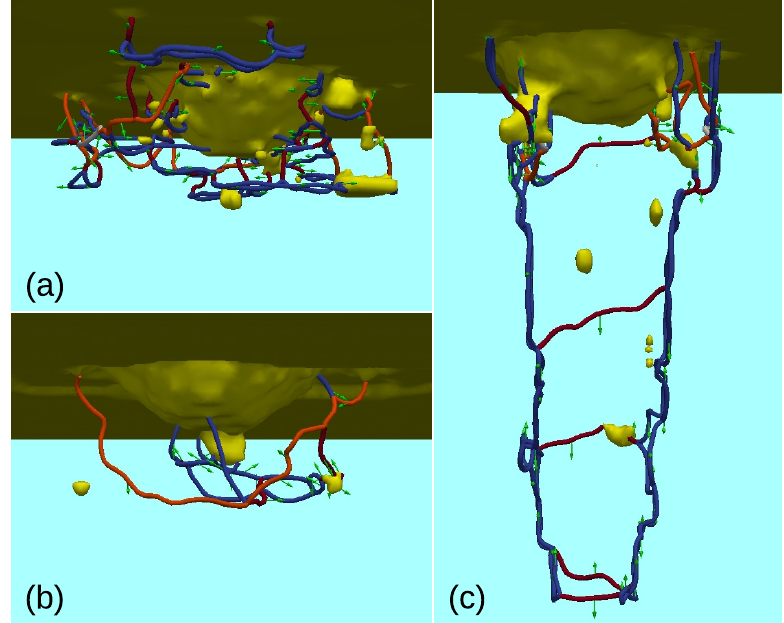
Figure 2. Dislocation networks generated for indentation into Ti. ( a ) Basal plane, ( b ) first prismatic plane, ( c ) second prismatic plane. Dislocations with Burgers vector 1 1 (cid:104) ¯2203 (cid:105) orange, 1 (cid:104) 0001 (cid:105) white, and 1 (cid:104) ¯110 (cid:105) blue. The deformed surface and other defects are colored 6 2 3 yellow. Original contribution of the